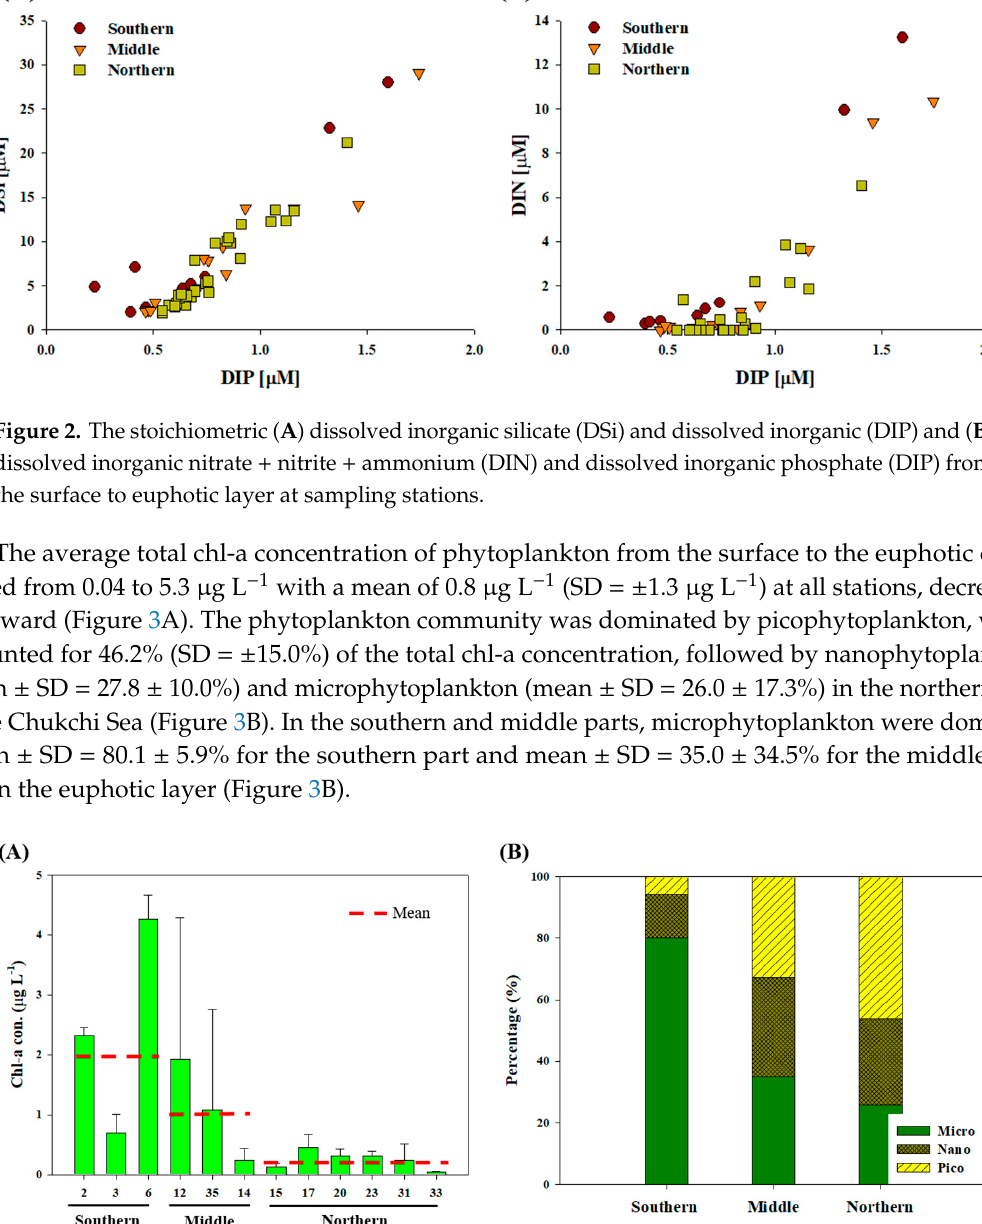
Figure 3. Average chlorophyll a (chl-a; µ g L − 1 ) concentration of phytoplankton within euphotic layer ( A ) in the study stations of the Chukchi Sea. ( B ) Relative chl-a (%) for size fraction of phytoplankton (0.7–2 µ m, 2–20 µ m and > 20 µ m; i.e., pico-, nano- and micro-phytoplankton, respectively). Data were sorted by station depths and divided into southern, middle, and northern. Error bar indicated standard deviation ( n = 2–5).